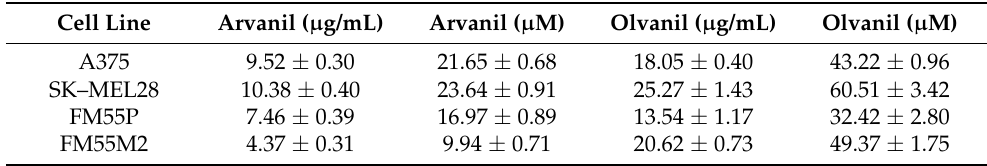
Table 1. The anti-proliferative effects of arvanil and olvanil administered singly in human malignant melanoma cell lines measured in vitro by the MTT